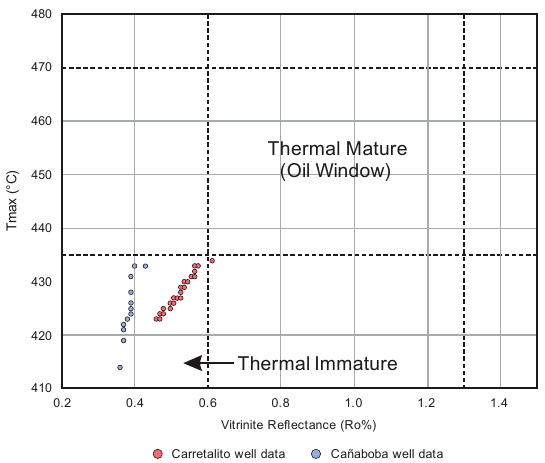
Figure 7. Graphic distribution of vitrinite reflectance analysis (%Ro), total organic carbon (TOC), total sulfur (TS), and hydrogen index (HI) of the Cerrejón Formation in the ANH-CAÑABOBA-1 Well, see Supplementary Materials Table S4.